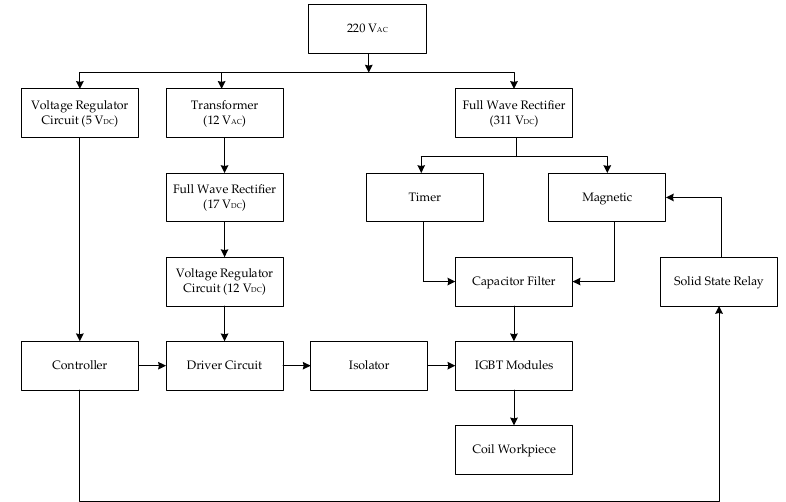
Figure 1. Block diagram of the thermal induction circuit.